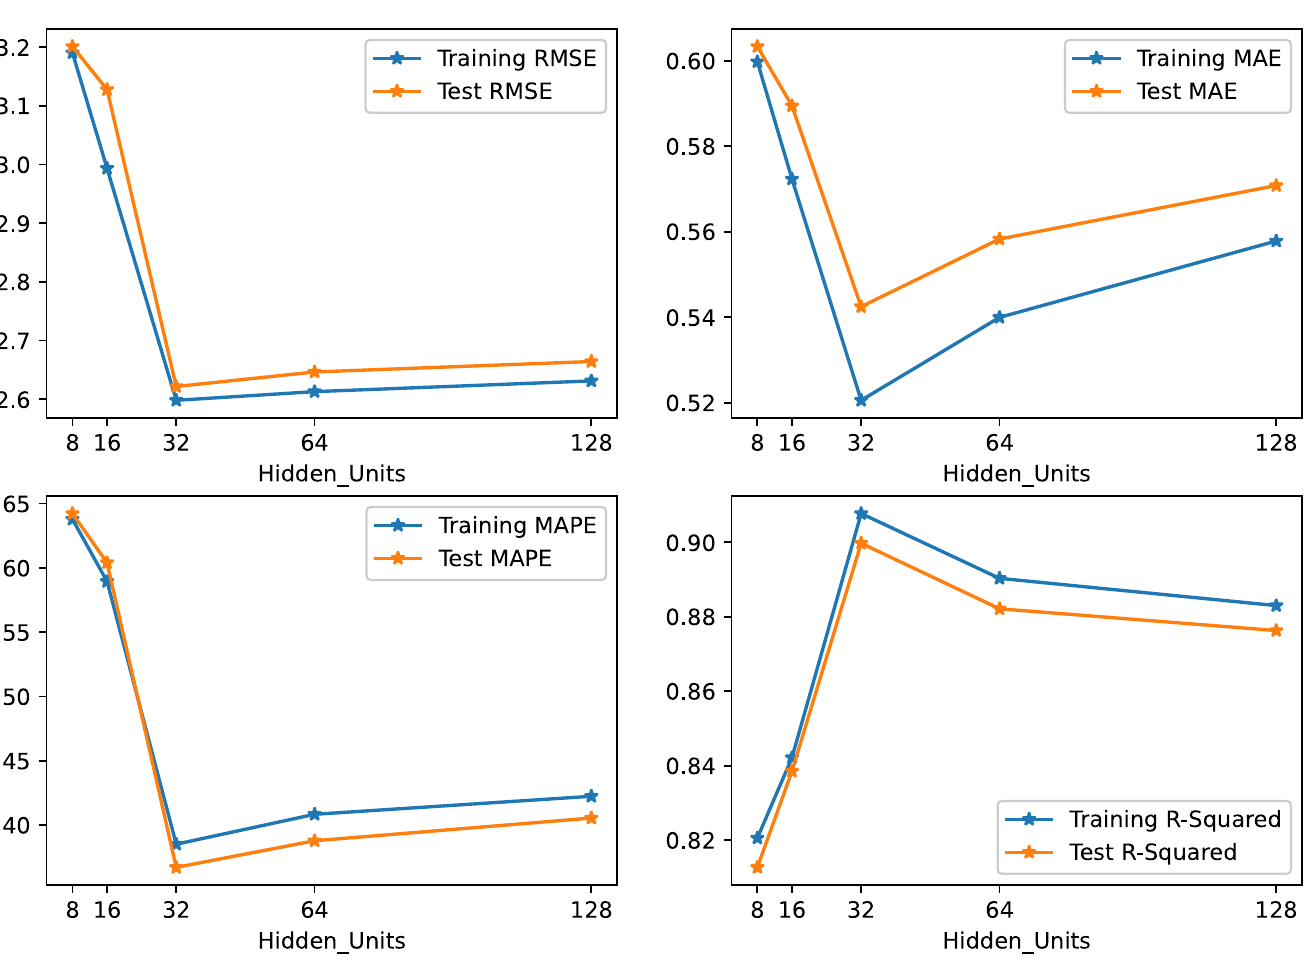
Fig 5. Comparison of RMSE, MAE, MAPE, and R Squared error results for different hidden units values.